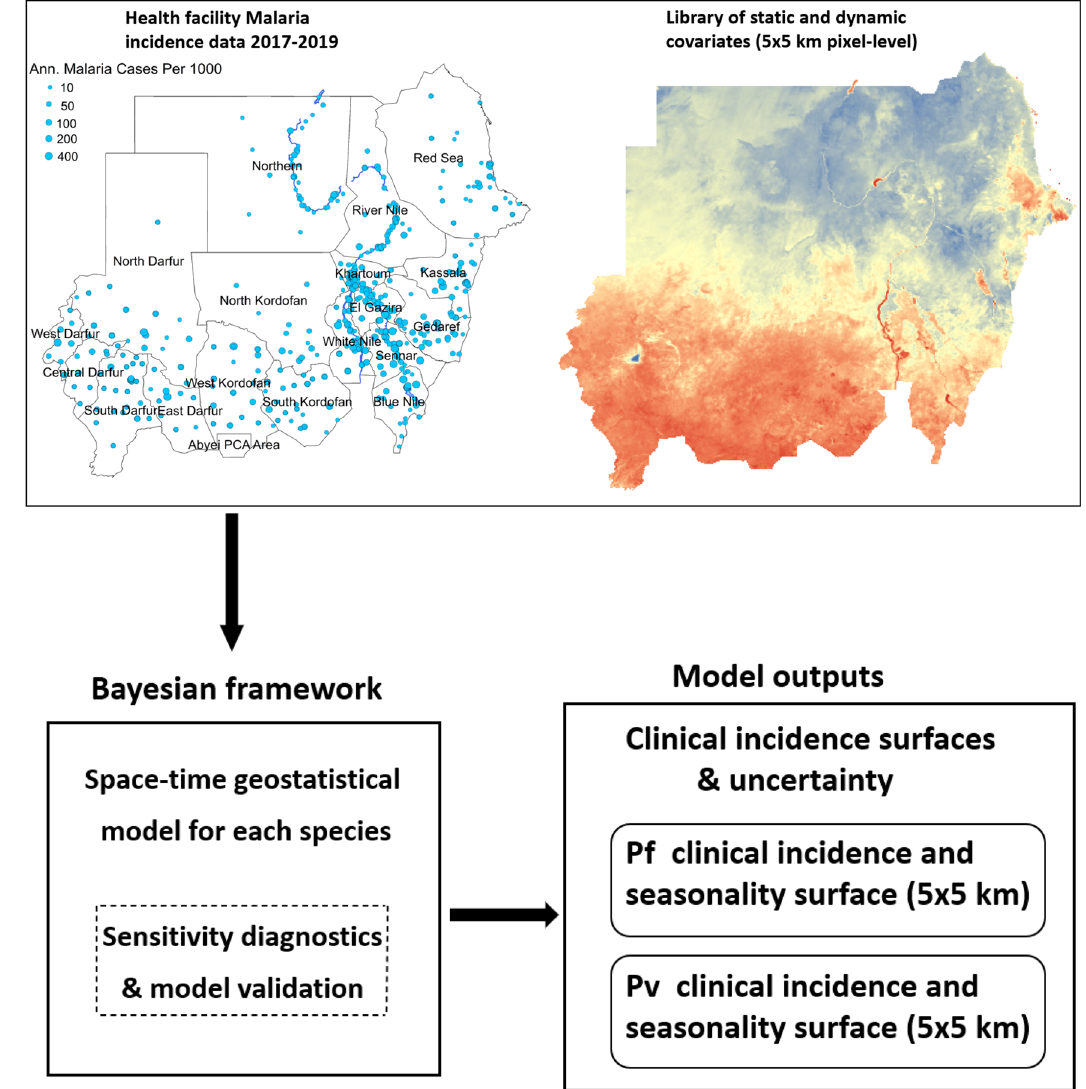
Figure 1. An overview of the input data, Bayesian framework structure and model outputs. This figure was created in R (https:// www.r- proje ct. org/) using the ggplot package.